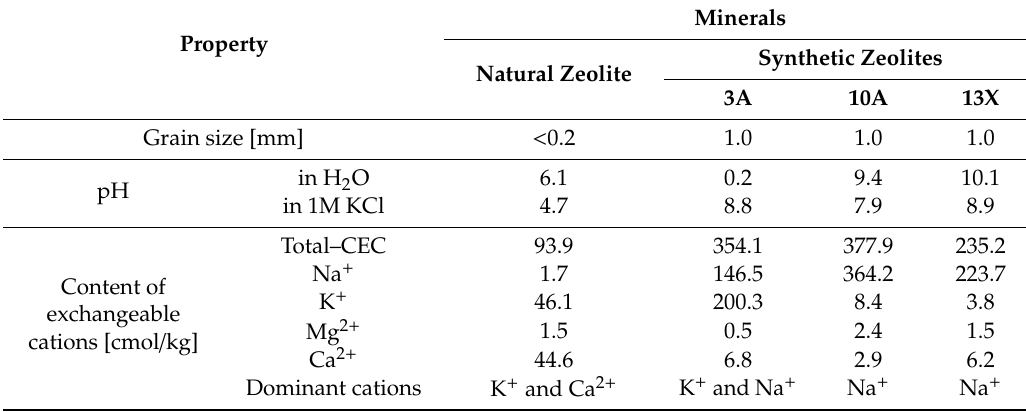
Table 1. The basic properties of each of the minerals used in the